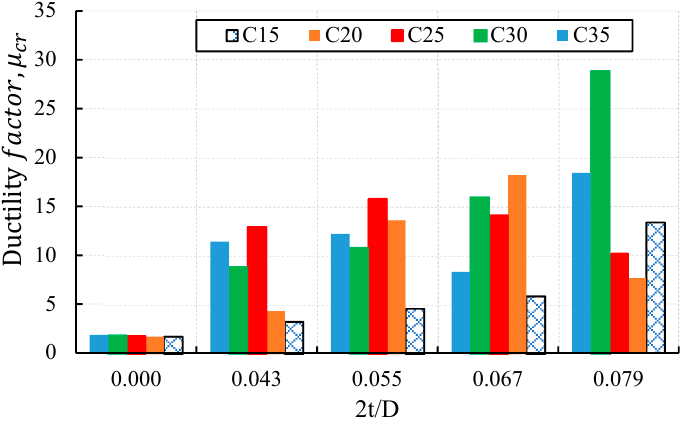
Figure 18. Ductility factor for different concrete classes and 2t/D ratios.